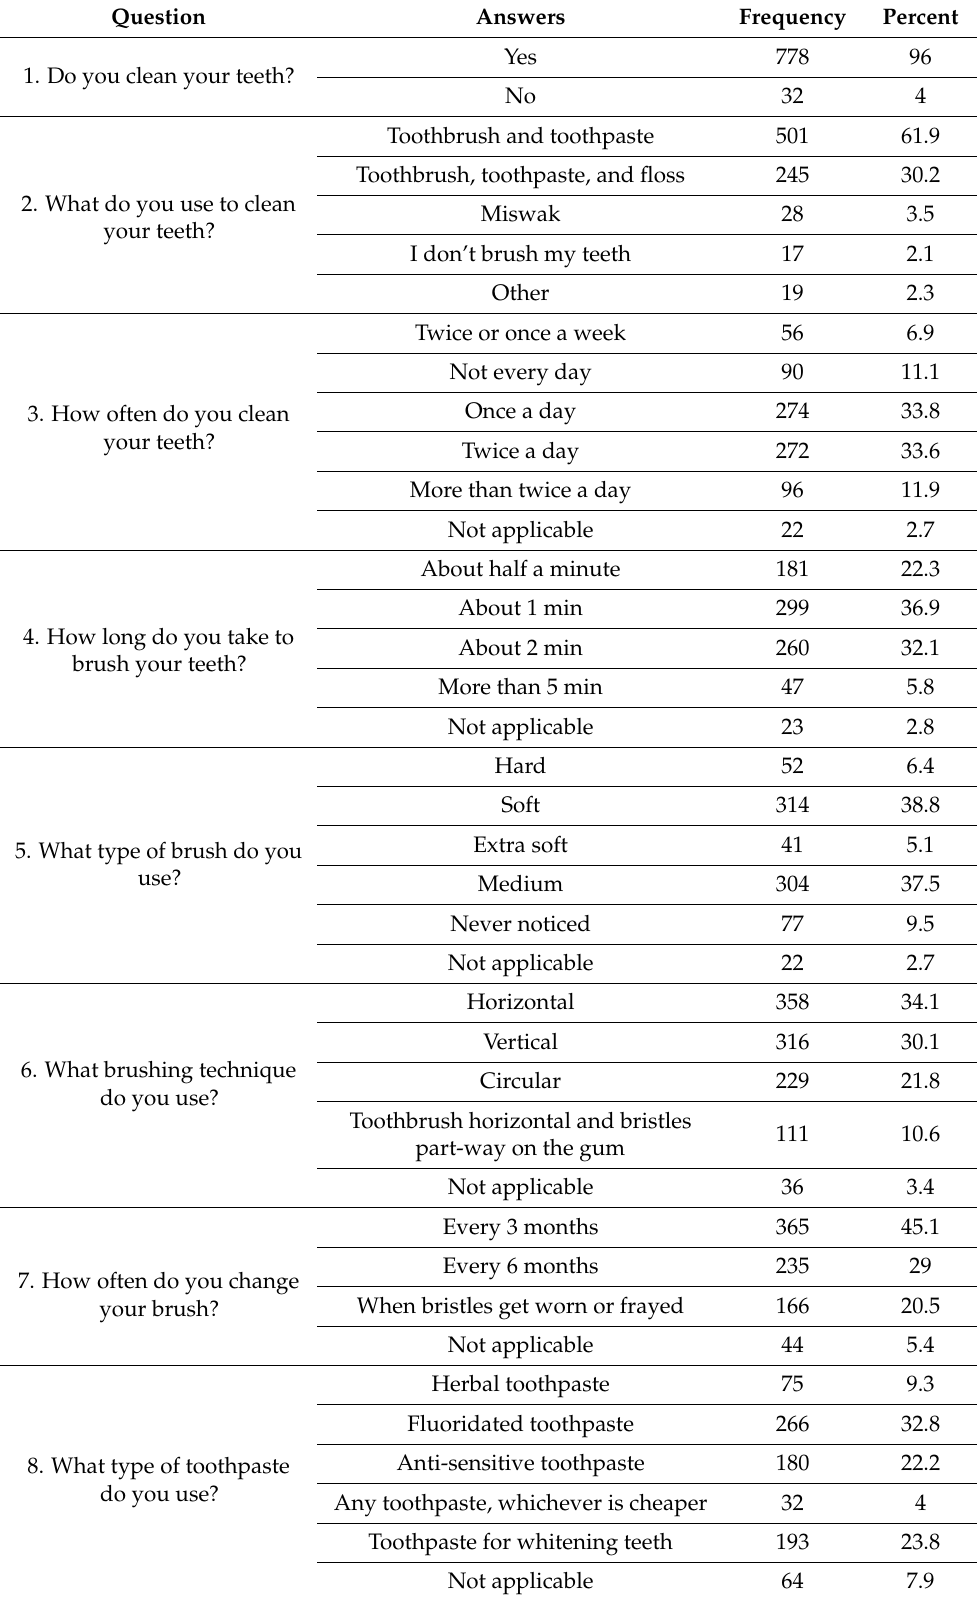
Table 3. Distribution of perception and knowledge on the use of a toothbrush and tooth paste among Saudi Arabian